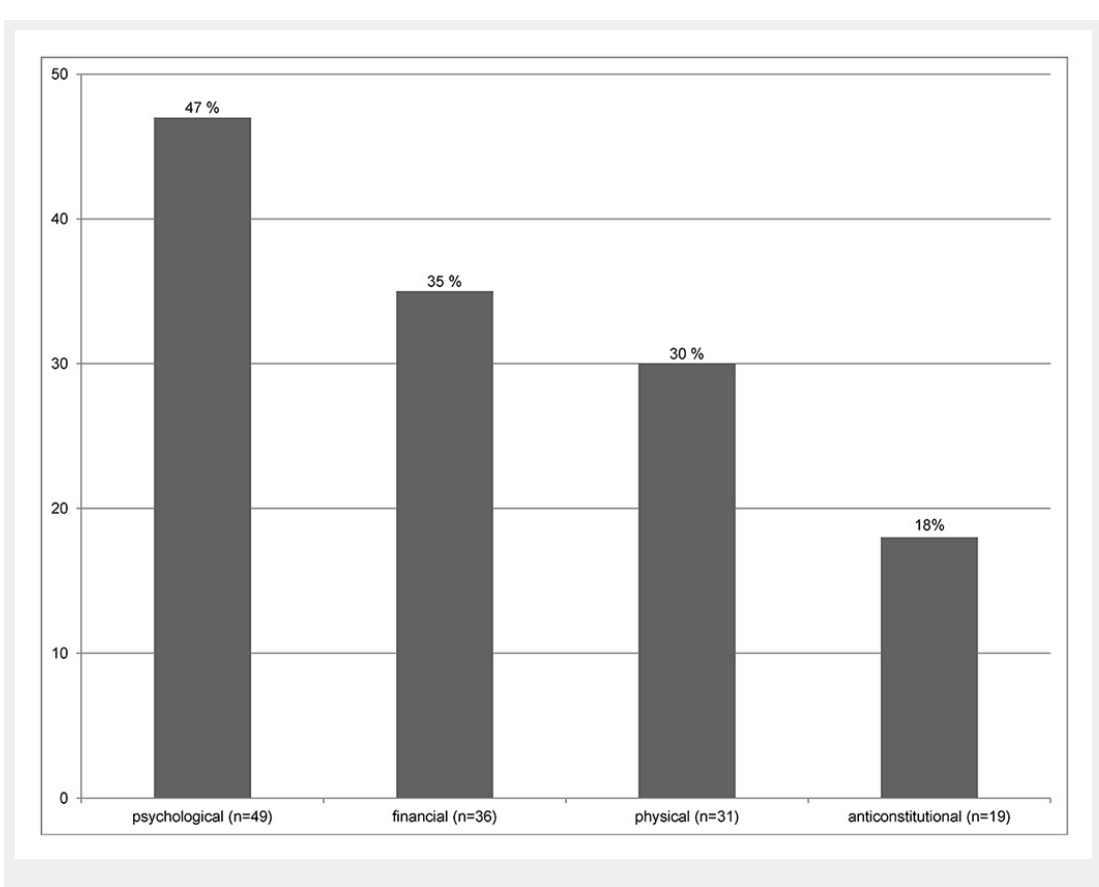
Figure 4 Types of abuse (overall 135 mentions in 104